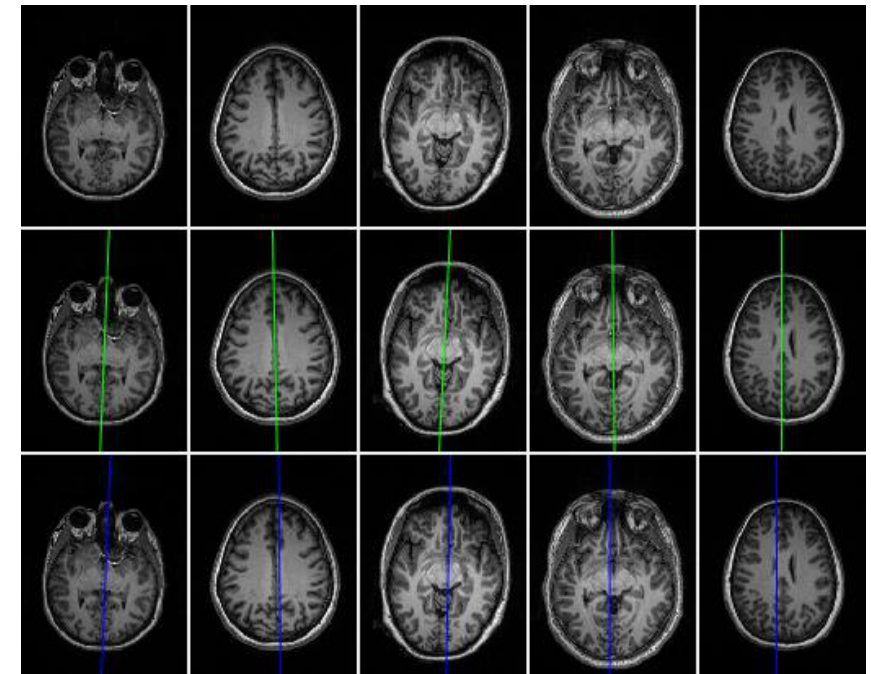
Figure 12. Visual comparison of the proposed algorithm with Ruppert et al. algorithm for extracting the symmetric axis (MSP) from real head volumes (the NFBS database [48]). First row, second row, and third row display the input images, the proposed algorithm results, and Ruppert et al. algorithm results, respectively.